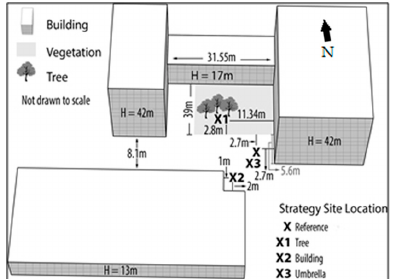
Figure 1. Diagram of the downtown setting. Light gray areas indicate vegetative surfaces (such as grass, flowers, and bushes), white surface areas indicate built areas (such as concrete and brick). X is the location of the reference site, X1 is the location of the tree strategy site, X2 is the location of the building strategy site, and X3 is the location of the umbrella strategy site. Diagram is not to scale.